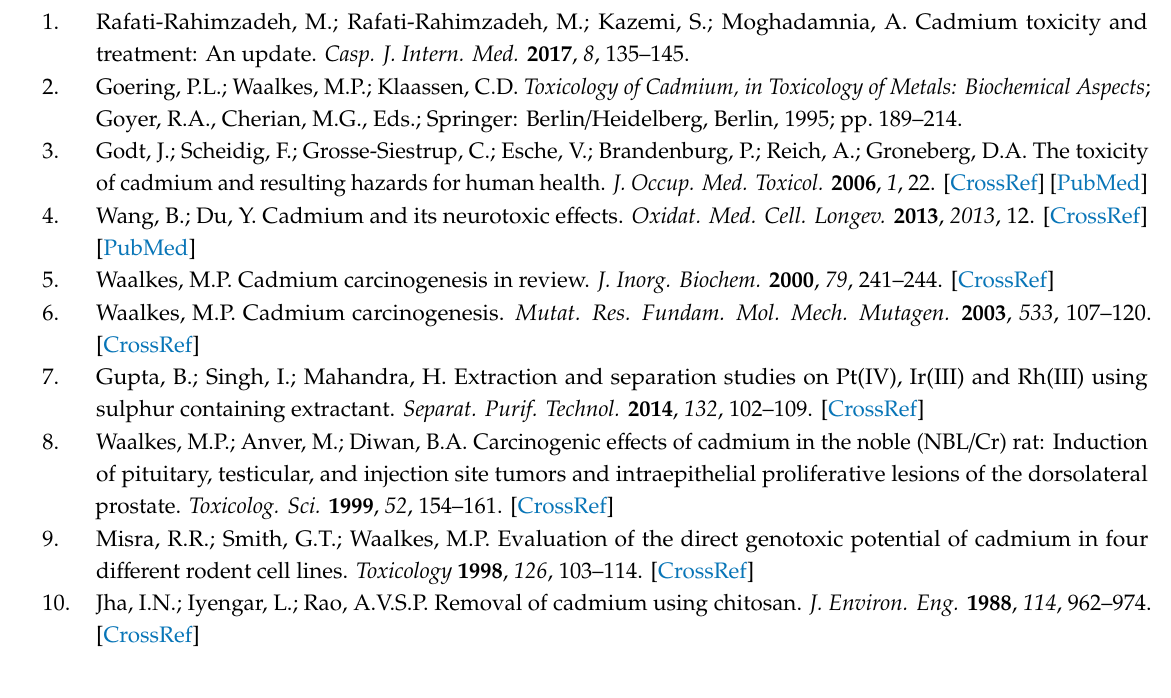
Figure S1: pH influence over the maximum adsorption capacity of pure chitosan, Figure S2: Influence of initial concentration over maximum adsorption capacity, Figure S3: Influence of contact time and temperature over adsorption capacity of chitosan, Figure S4: Kinetic models for Cd (II) adsorption onto Chitosan at di ff erent temperatures, Figure S5: Adsorption isotherms obtained for Cd adsorption on chitosan, Figure S6: Log Kd-1 / T plot obtained for Cd adsorption on Chitosan, Table S1: Kinetic parameters for the adsorption of Cd (II) onto chitosan, Table S2: Parameters of isotherm model for adsorption of Cd (II) onto chitosan, Table S3: Thermodynamic parameters for adsorption of Cd (II) onto